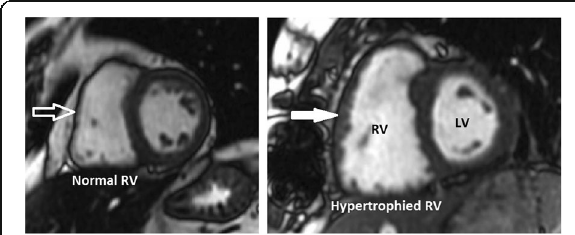
Fig. 13 Right ventricular wall hypertrophy. Short axis SSFP